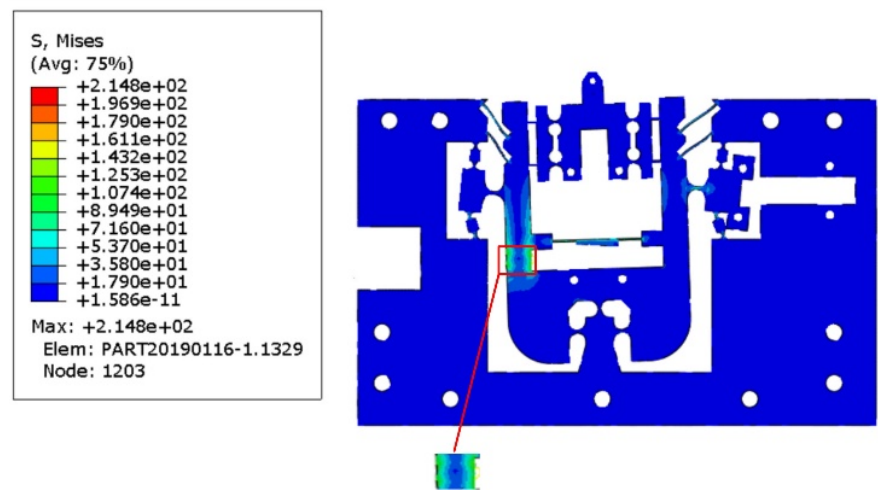
Figure 11. Stress simulation of the FTS.